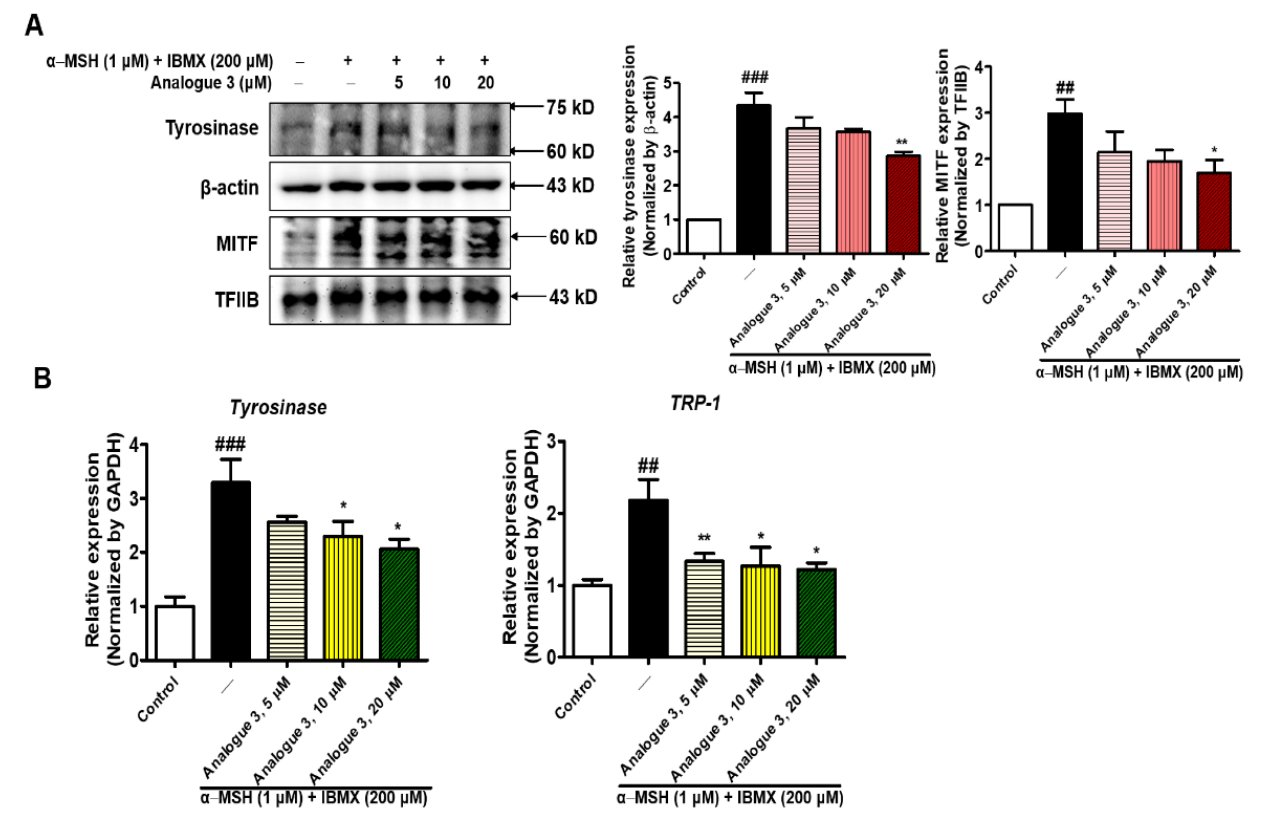
Figure 12. Effect of analog 3 on the expressions of melanogenesis ‐ related proteins and genes in B16F10 melanoma cells stimulated with α –MSH/IBMX. ( A ) Cells were pre ‐ treated with analog 3 for 1 h and then exposed to α –MSH/IBMX in the presence or absence of analog 3 . Cytosolic and nuclear extracts were subjected to Western blot to determine the protein levels of tyrosinase and MITF, re ‐ spectively. The histograms show band densities of tyrosinase normalized versus β‐ actin and MITF normalized versus TFIIB. ( B ) Tyrosinase and tyrosinase ‐ related protein 1 mRNA expressions. Results are the means ± standard errors of three different experiments. The symbols * and # represent signif ‐ icant differences. ### p < 0.001 and ## p < 0.01 for the non ‐ treated control versus α –MSH/IBMX stimu ‐ lated cells; * p < 0.05 and ** p < 0.01 for α –MSH/IBMX ‐ treated cells versus analog 3 plus α –